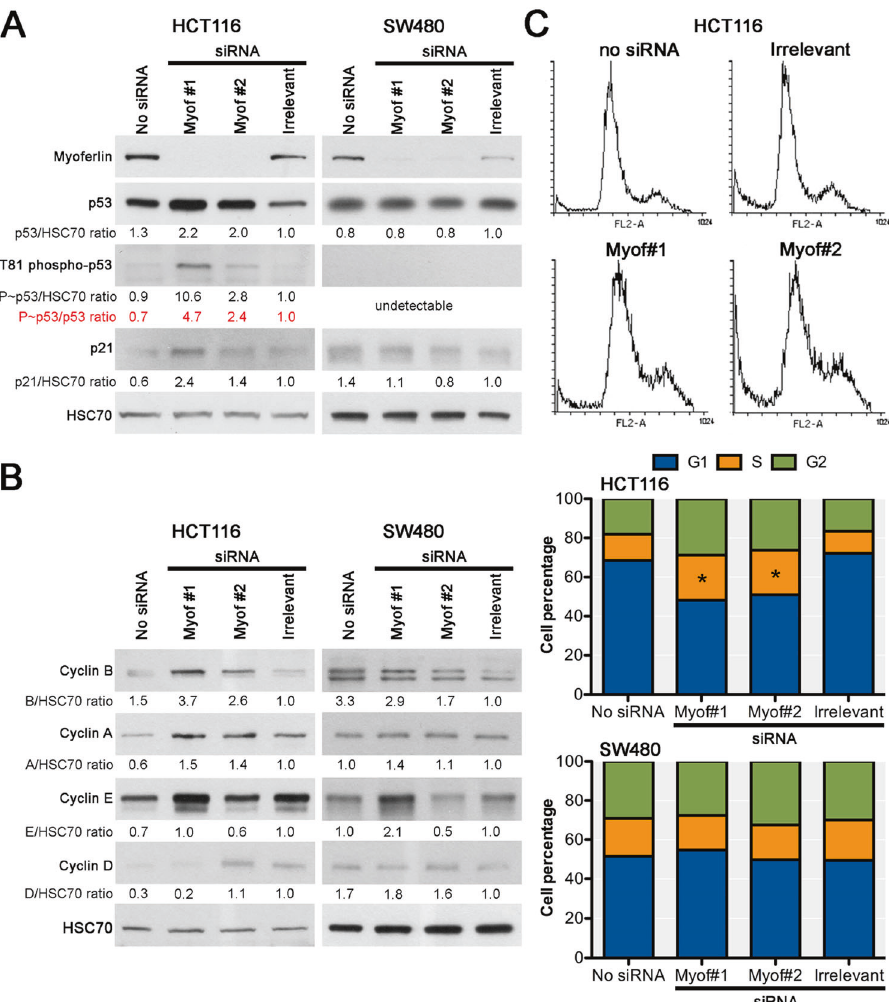
Fig. 4 Effects of myoferlin silencing on p53 activation and cell cycle progression. a p53 activation by Thr81 phosphorylation and subsequent p21 abundance were evaluated in HCT116 and SW480 48h after myoferlin silencing. b Cyclin abundance was evaluated by western-blot in HCT116 and SW480 48h after myoferlin silencing. Total protein extracts (10 μ g) were subjected to SDS-PAGE followed by western blot analysis with speci fi c antibodies. HSC-70 was used as a loading control. c Cell cycle was analyzed by fl ow cytometry after propidium iodide incorporation in HCT116 and SW480 48h after myoferlin silencing. Distribution of FL2 fl uorescence (propidium iodide) was shown in HCT116. Proportion of cells in G1, S or G2 was shown in HCT116 and SW480. One representative experiment out of three is illustrated. * P <